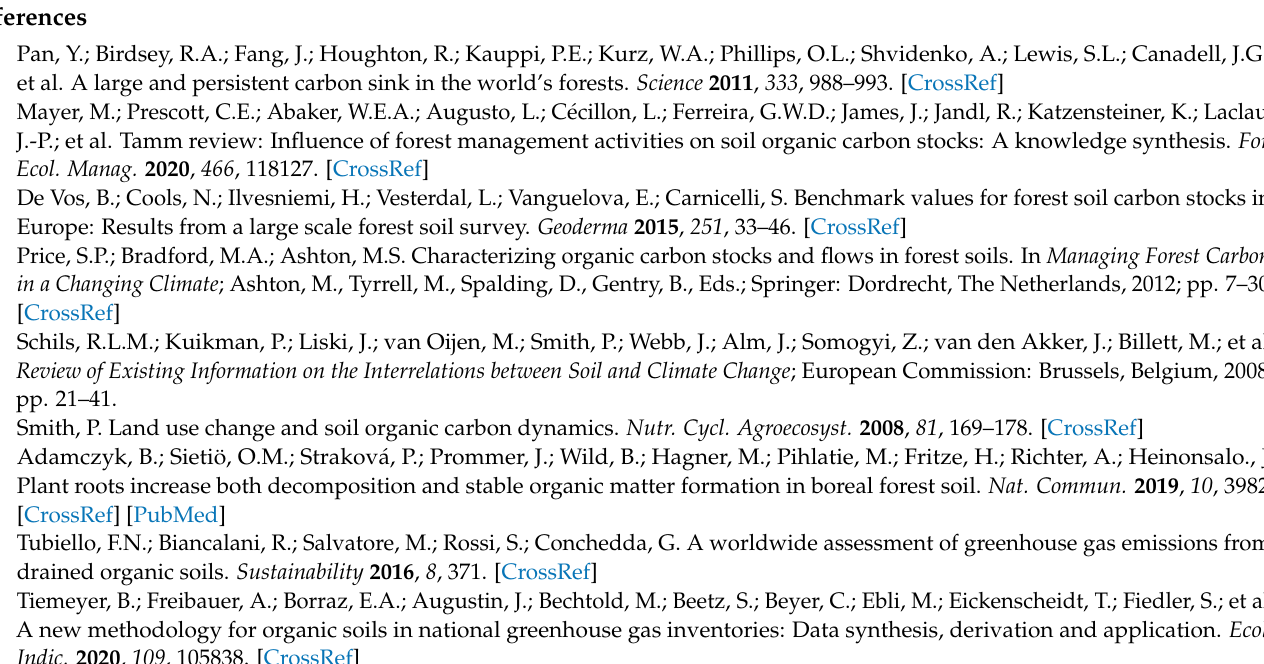
Table S2: Soil bulk density in forest land with organic soil in